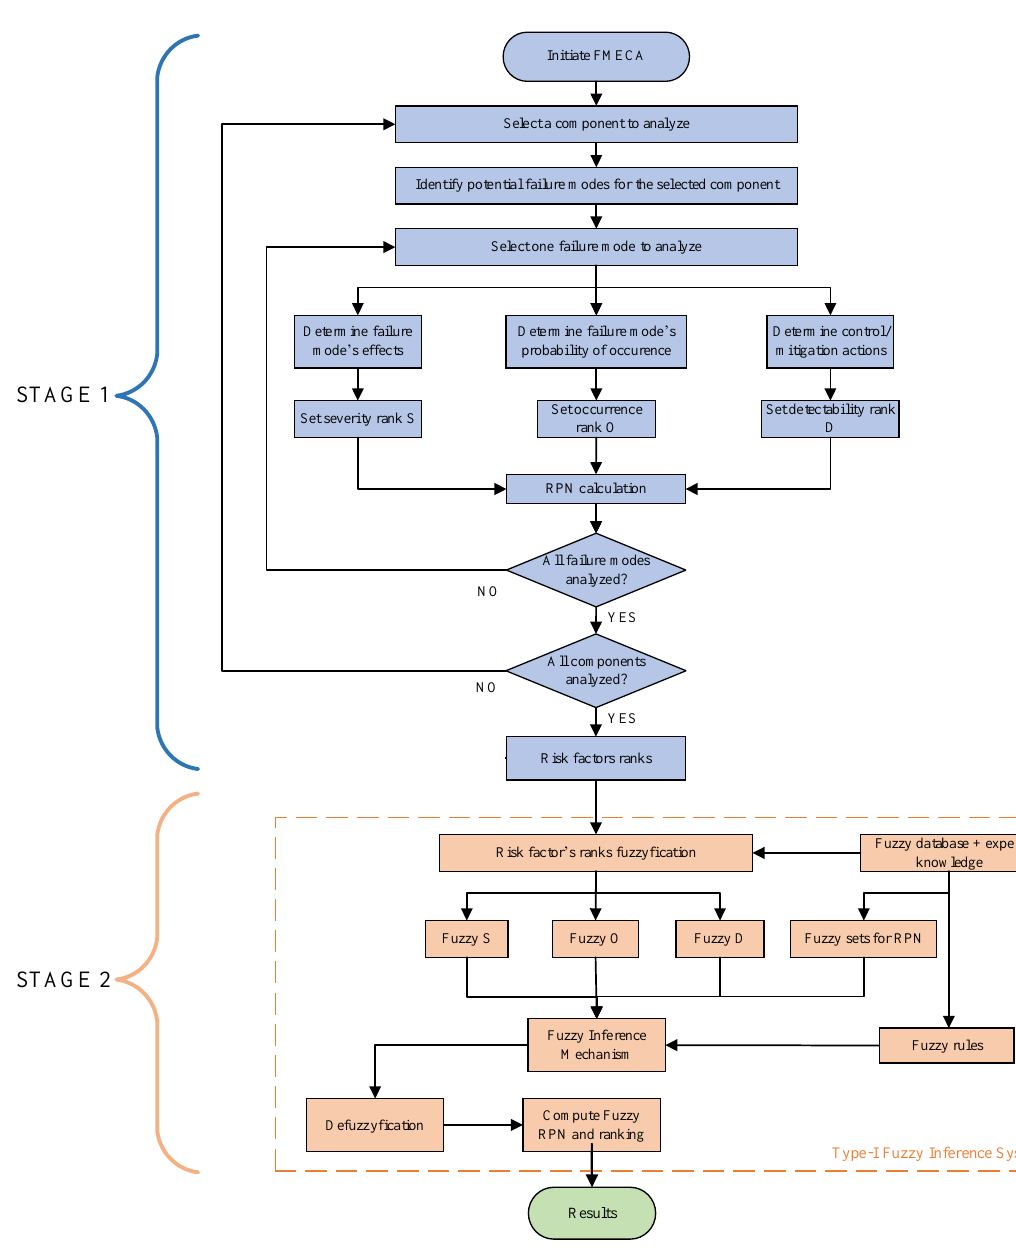
Figure 5. Flowchart for the proposed FMECA approach based on fuzzy systems.